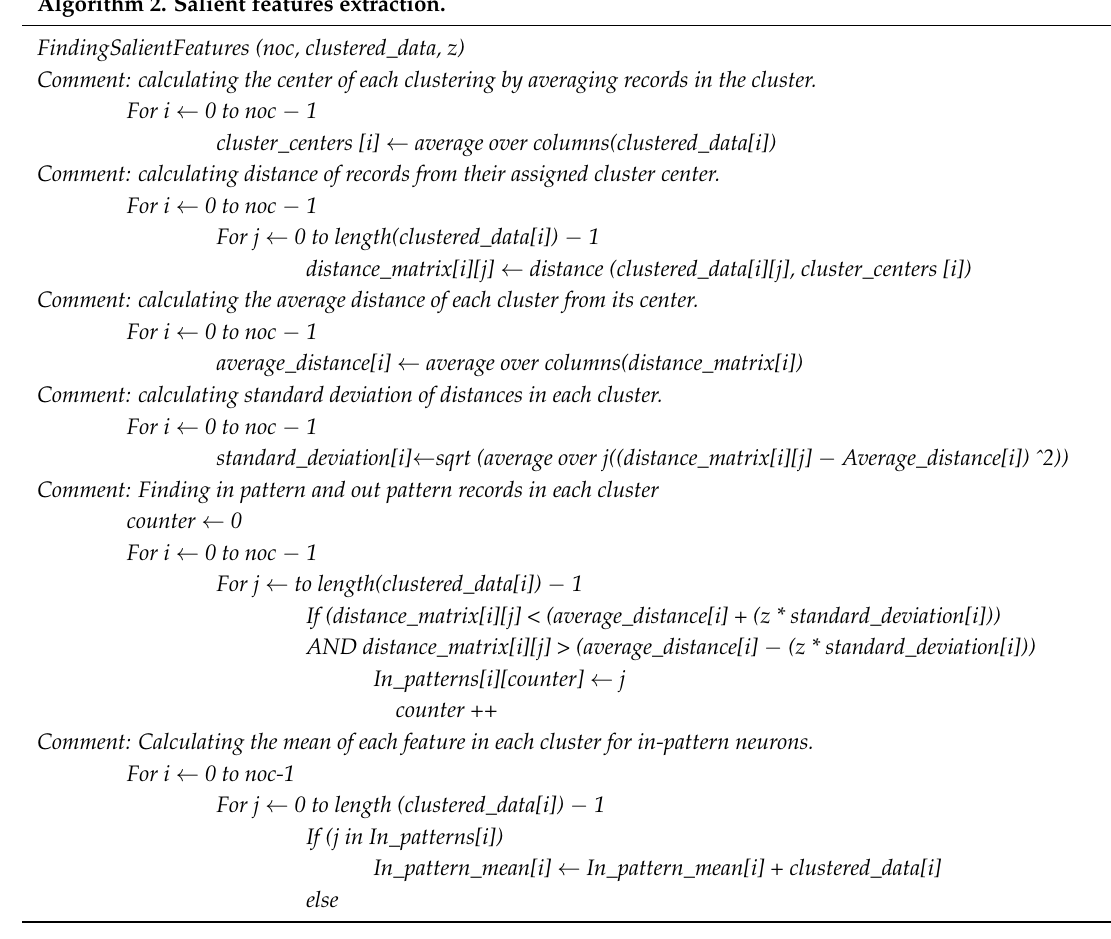
Algorithm 2. Salient features